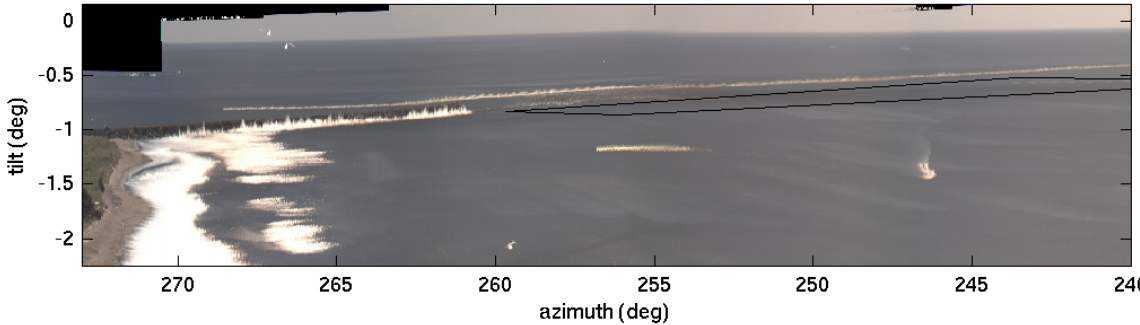
Figure 4. Example of merged pan “brightest” image from 16 July 2017 showing regions of wave breaking during the ten minutes of data collection, for example, over the shoreline and sand bar and against the jetty. Anomalous streaks correspond to boat wakes. The SWS boundaries are shown offshore as a black line. The figure is shown with a vertical exaggeration of 4:1 to improve interpretation.